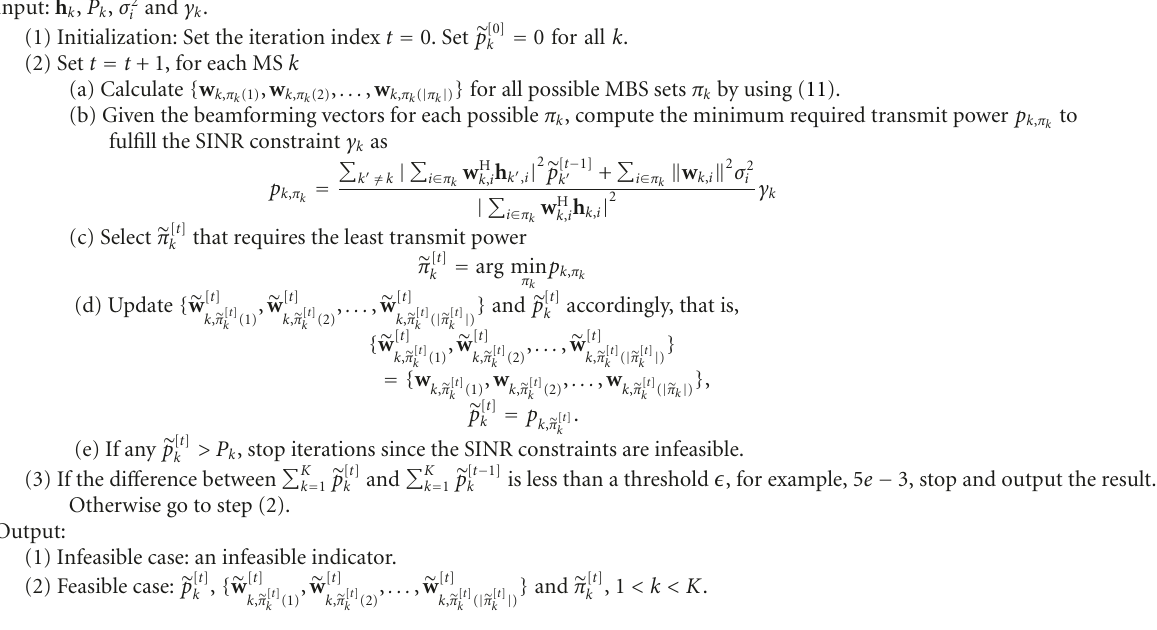
Algorithm 1: Joint TPC and receive beamforming with adaptive MBS